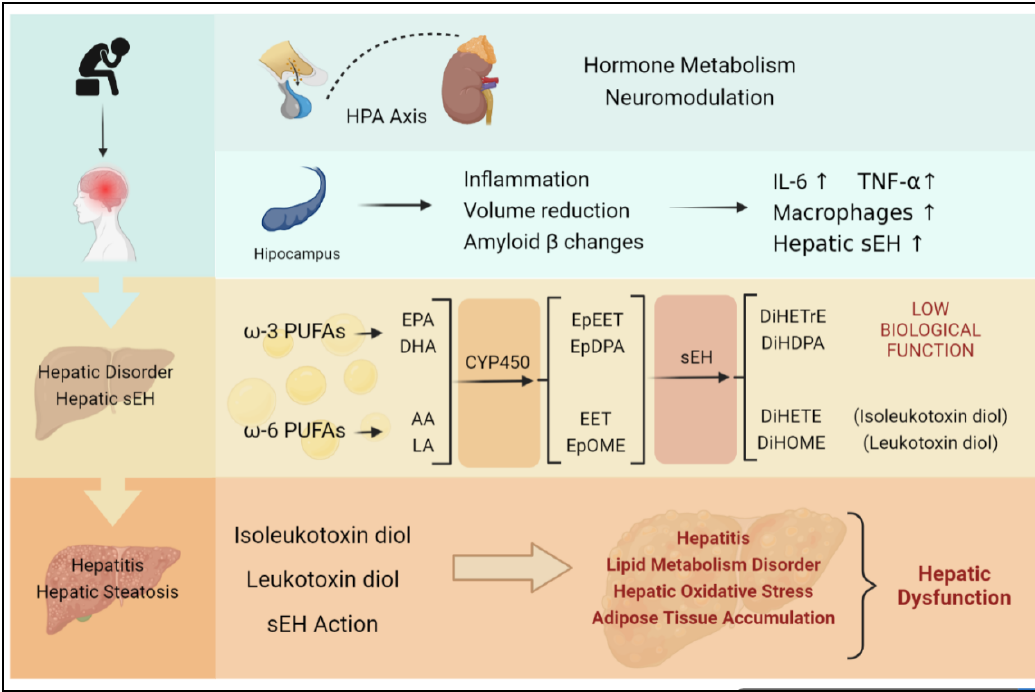
Figure 4. Chronic stress is largely induced by continuous negative emotion, which is likely to de- velop into depression. Both chronic stress and depression can activate the HPA axis, stimulate the hippocampus, and induce inflammation, as well as hepatic sEH upregulation specifically. The upreg- ulation of sEH in the liver can lead to an imbalance in epoxide metabolism and excessive production of DiHETrE, DiHDPA, DiHOME (containing leukotoxin diol), and DiHETE (containing isoleukotoxin diol). The degrading of EET suppresses the anti-inflammation effect. At the same time, toxic diols lead to hepatic dysfunction, including hepatitis, lipid metabolism disorder, hepatic oxi- dative stress, and adipose tissue accumulation, which directly promotes the occurrence of nonalco- holic hepatitis.